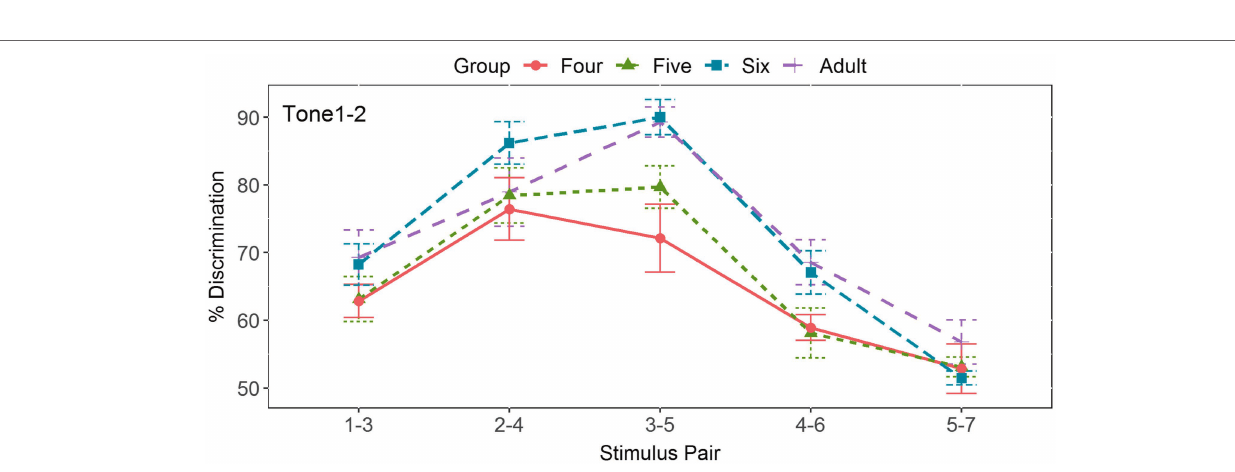
FIGURE 5 | Values of all tokens for each child plotted against children’s chronological age for the Tone 1-2 continuum. The shadow area represents the 95% confidence interval of the best-fit line from linear regression models.